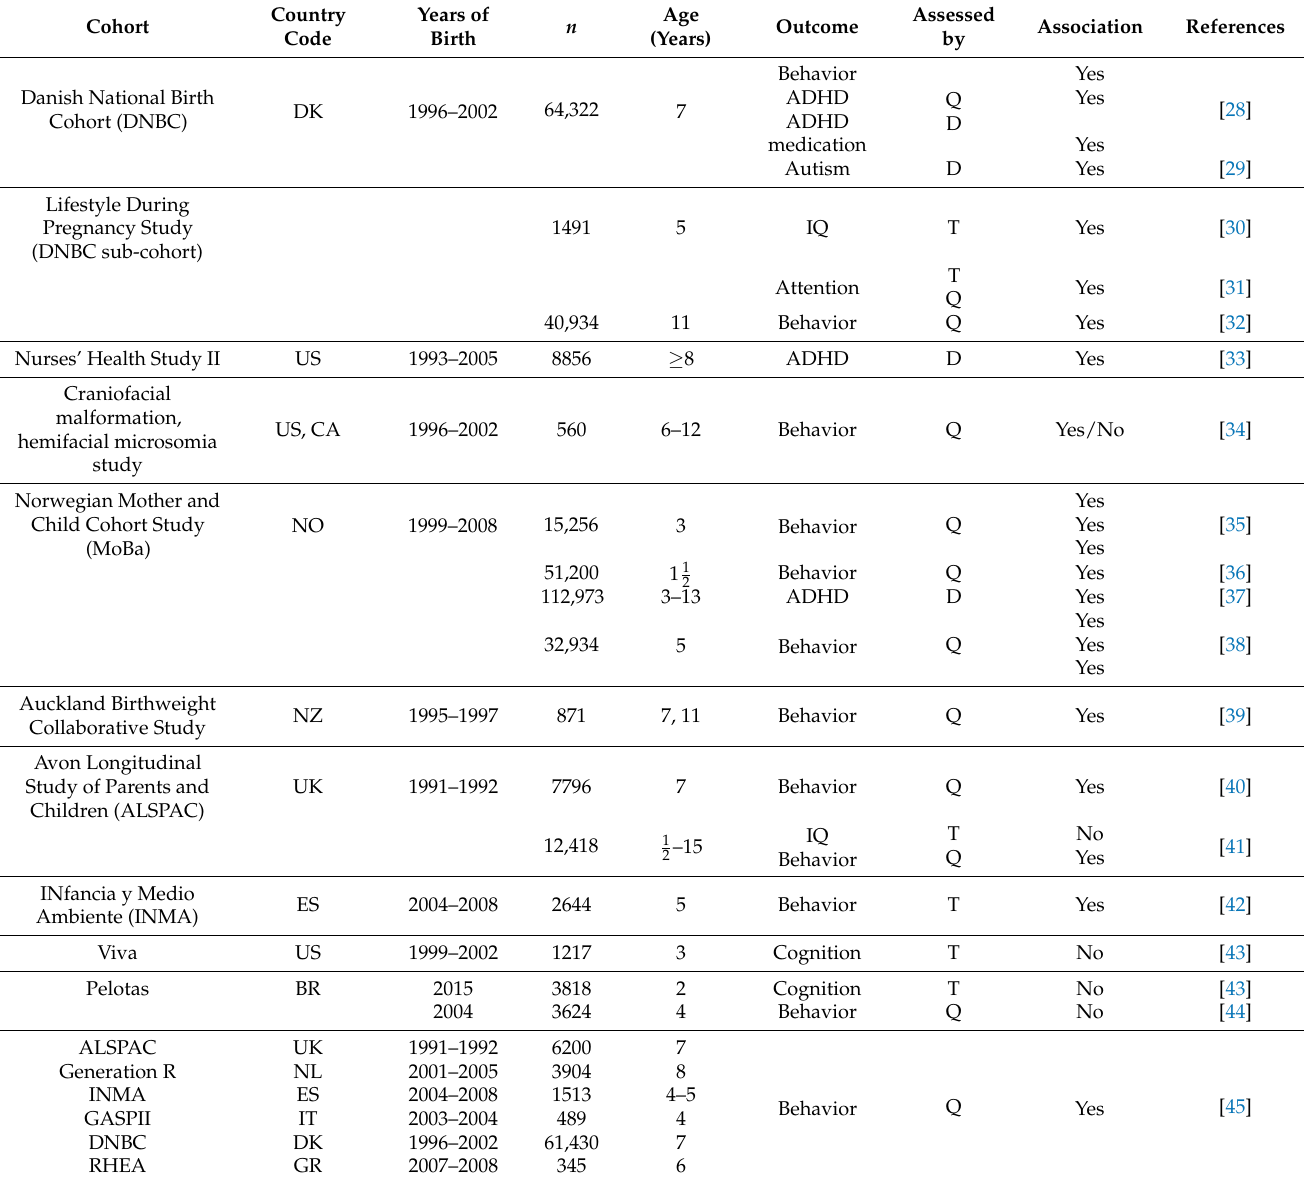
Table 1. Paracetamol intake estimated based on maternal